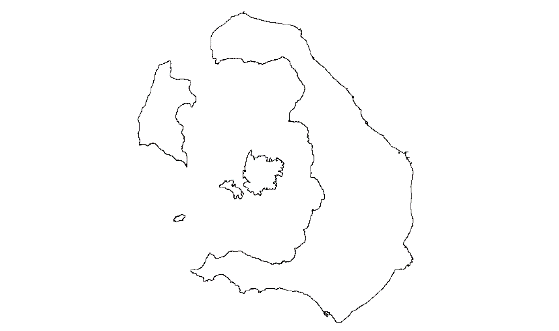
Figure 12. The automatically generated strip polygon of 51 meters width.